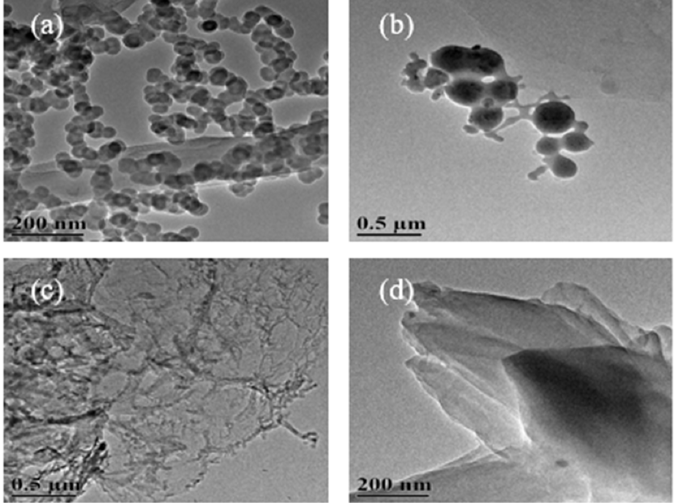
Figure 5. TEM images of carbon nanostructures at 800 °C: ( a ) 1CMC concentration carbon nanostructures; ( b ) 2CMC concentration carbon nanostructures; ( c ) 5CMC concentration carbon nanostructures; ( d ) 10CMC concentration carbon nanostructures.